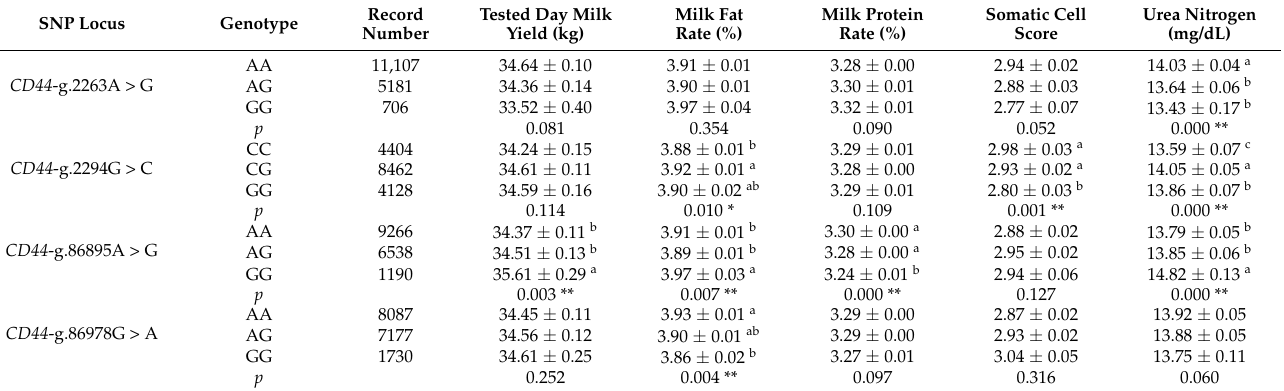
Table 5. Effects of different genotypes of SNPs of CD44 gene on production performance of